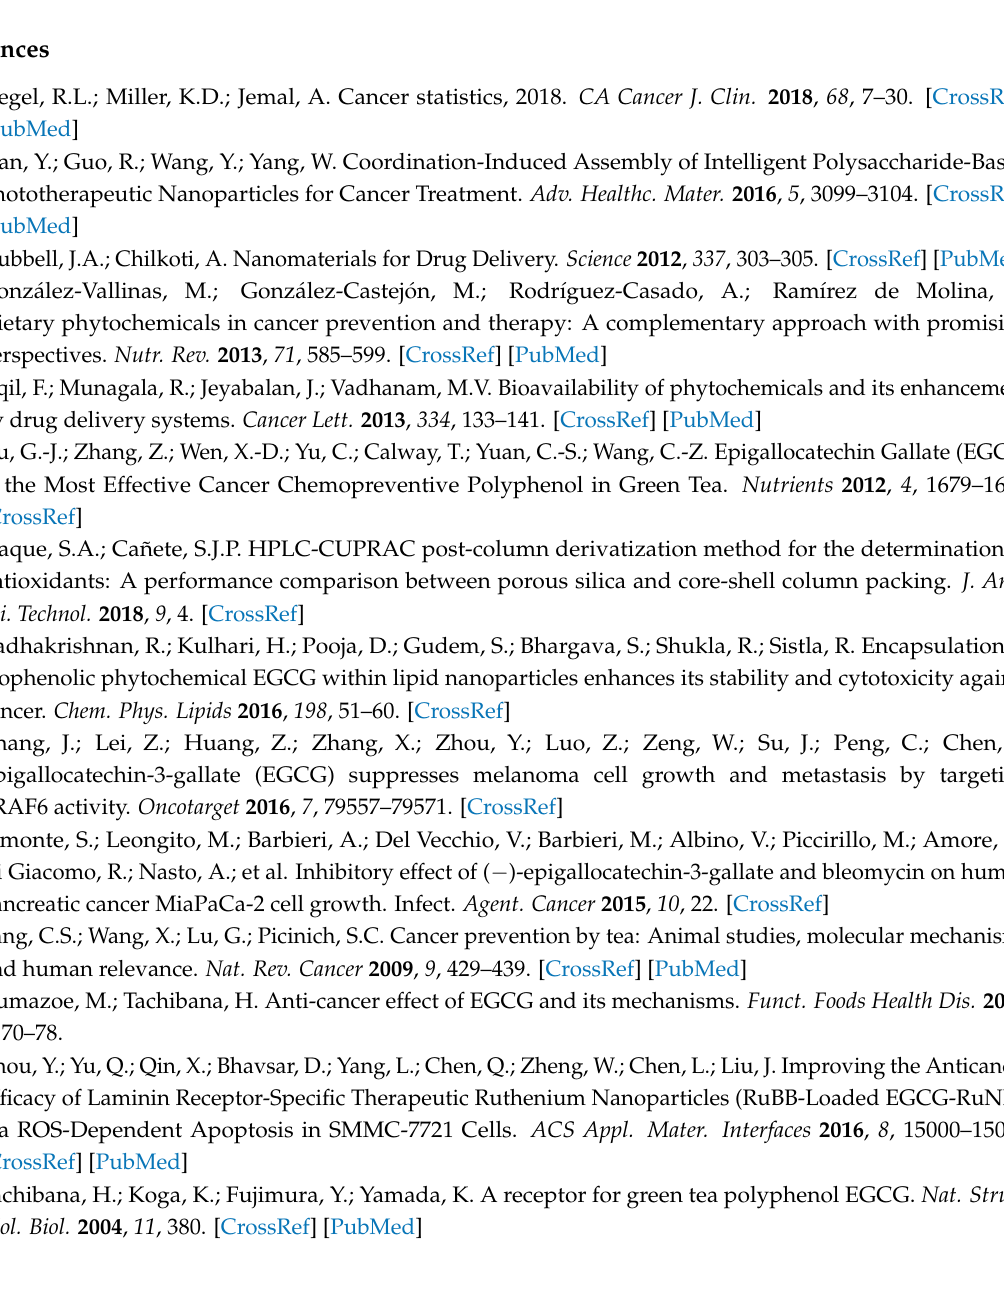
Figure S1: Quantification of EGCG loading on GNP; Figure S2: E-GNPs stability studies; Figure S3: Representative TEM images at high magnification (28,500 × ); Figure S4: Laminin receptor expression in cancerous and noncancerous cell